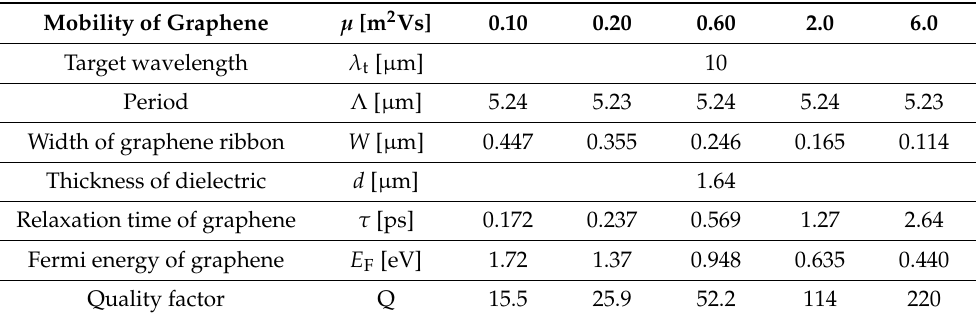
Figure 7. ( a ) Normal emissivity spectrum for graphene ribbon metasurface with different electron mobilities of graphene. The target wavelength is 10 µm, and the electron mobilities of graphene are µ = 0.10, 0.20, 0.60, 2.0, and 6.0 m 2 /Vs. ( b ) Quality factor for different mobilities of graphene, and bandwidth parameter β . Normal emissivity is calculated from RLC circuit model to obtain the quality factor. Table 2. Design parameters and obtained quality factors of graphene ribbon metasurface used for the calculation in Figure